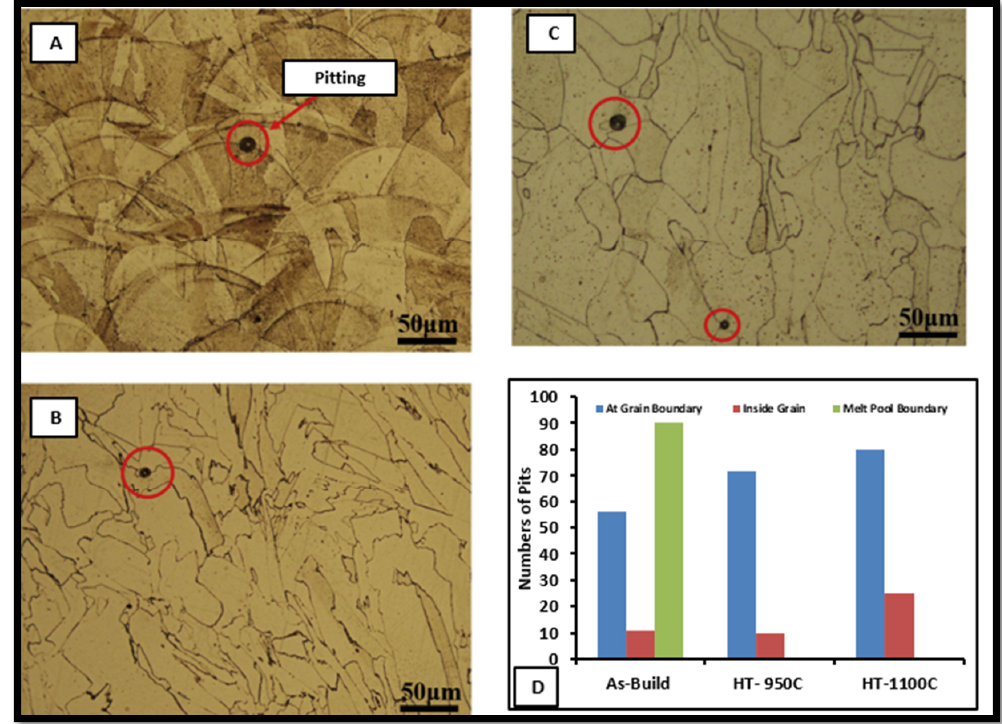
Figure 19. Micrographs and pit formation at ( A ) as-built, ( B ) HT 950’C, ( C ) HT 1100. ( D ) Number of pits at different conditions [45].